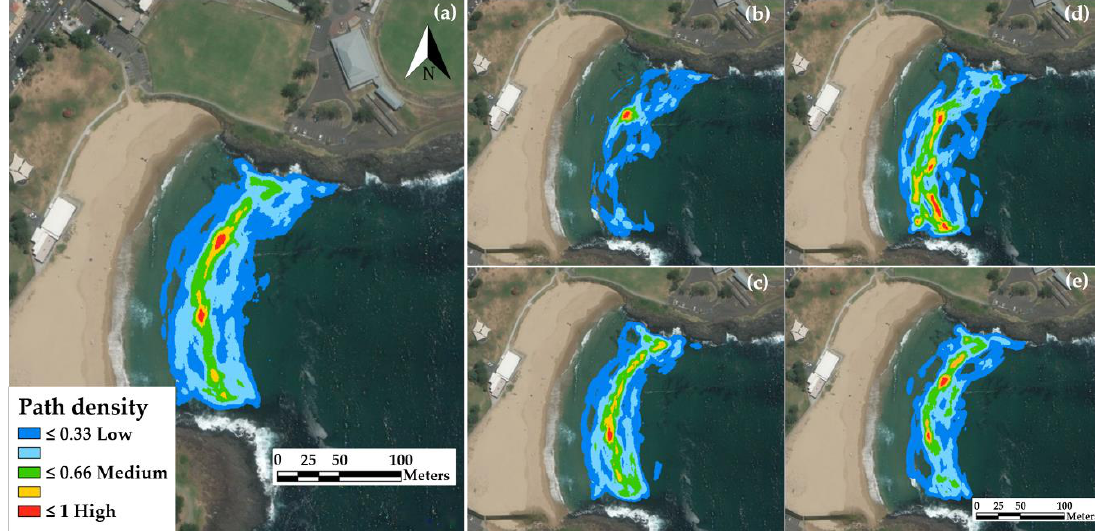
Figure 3. Density heat maps drawn from ( a ) the complete pool of stingray movement paths ( n = 93); ( b ) from those paths occurring during low tide ( n = 34), ( c ) high tide ( n = 59), ( d ) midday ( n = 32), and ( e ) afternoon ( n = 61).